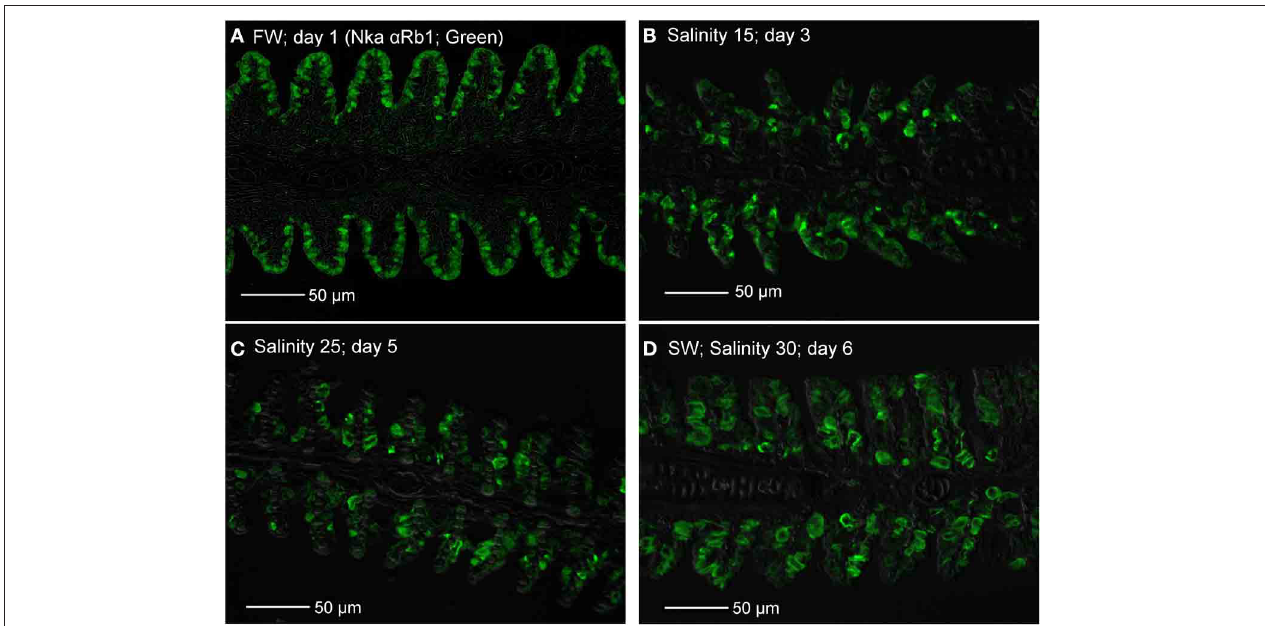
FIGURE 15 | Immunofluorescent staining of Na + /K + -ATPase (Nka; green) using the anti-NKA α Rb1 antibody, for localization of mitochondrion-rich cells in the gills of Anabas testudineus kept in (A) freshwater on day 1 (FW; control), or after 24h of exposure to (B) salinity 15 on day 3, (C) salinity 25 on day 5, or (D) salinity 30